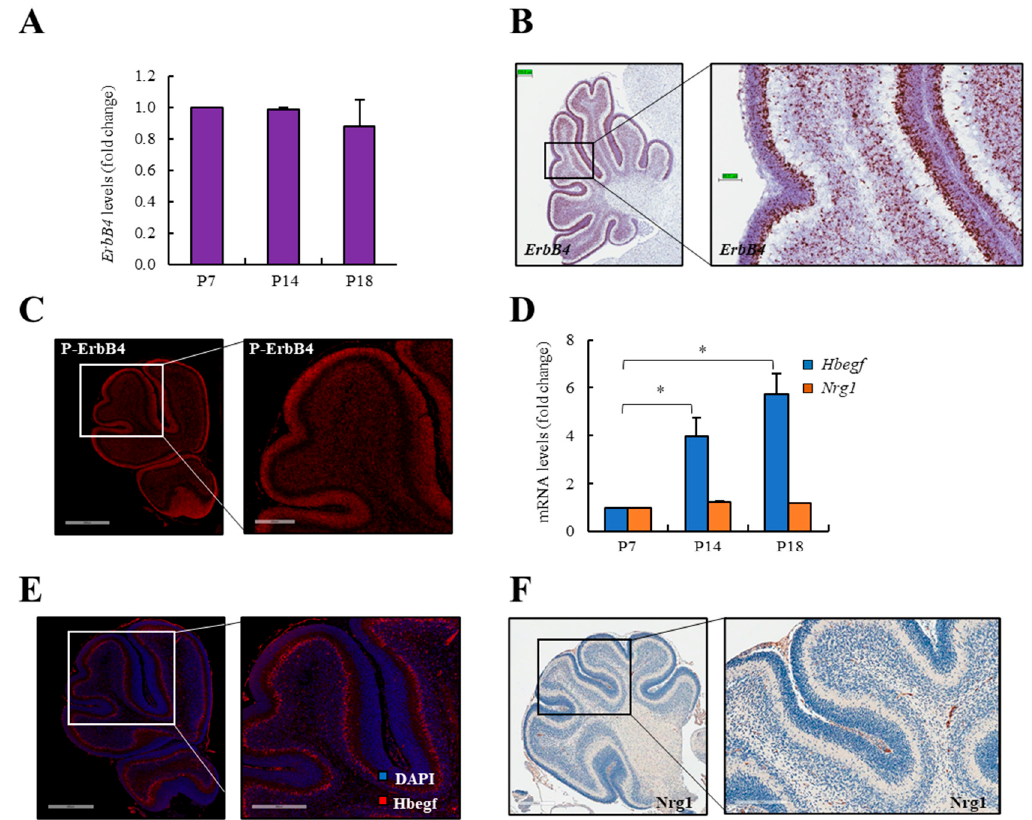
Figure 1. ERBB4 is expressed in the external germinal layer during cerebellum development. ( A ) ErbB4 mRNA expression in mice cerebellum at postnatal day 7 (p7), p14, and p18. ( B ) Representative RNAscope images of ErbB4 mRNA expression in p10 mouse cerebellum ( n ≥ 3). Scale bars: left = 199.8 µ m and right = 49.91 µ m. ( C ) Representative immunofluorescence images of P-ERBB4 protein expression in p7 mouse cerebellum ( n ≥ 3). Scale bars: left = 600 µ m and right = 200 µ m. ( D ) Hbegf and Nrg1 mRNA expression in mice cerebellum at p7, p14, and p18. ( E ) Representative immunofluorescence images of HBEGF protein expression in p7 mouse cerebellum ( n ≥ 3). Scale bars: left = 500 µ m and right = 300 µ m. ( F ) Representative immunohistochemistry images of NRG1 protein expression in p7 mouse cerebellum. Scale bars: left = 400 µ m and right = 200 µ m. * p ≤